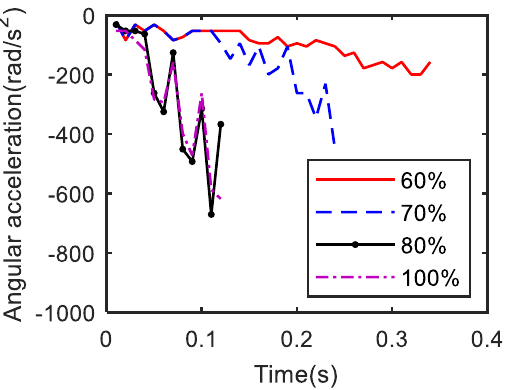
Figure 14. AMT input shaft’s angular acceleration curves under different duty cycles of TB solenoid valve.